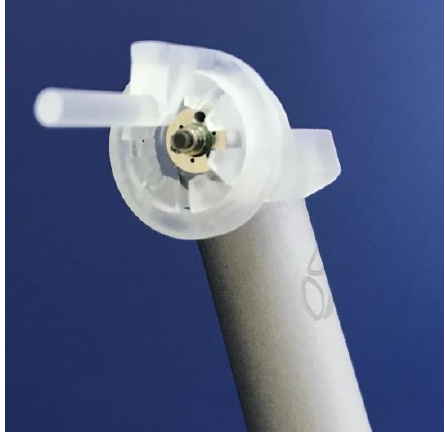
Figure 1. Adjustable rotating spacer, providing tip-to-tissue distance of 10 mm from 1.3 × 6.3 mm sapphire tip, used in this study.